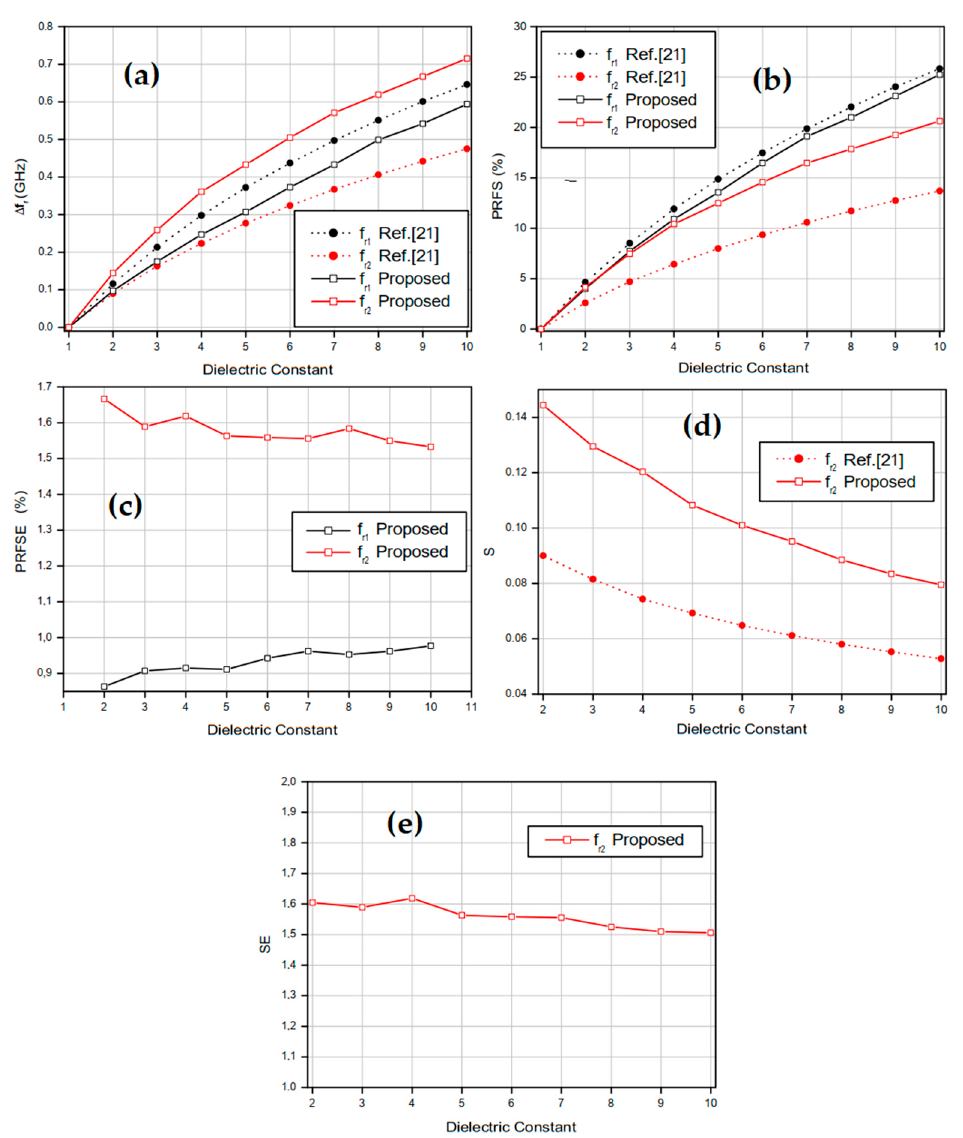
Figure 4. Sensitivity parameters results: ( a ) Resonant shift ( ∆ f r ); ( b ) percentage relative frequency shift (PRFS); ( c ) percentage resonant frequency shift enhancement (PRFSE); ( d ) sensitivity (S); ( e ) sensitivity enhancement (SE).